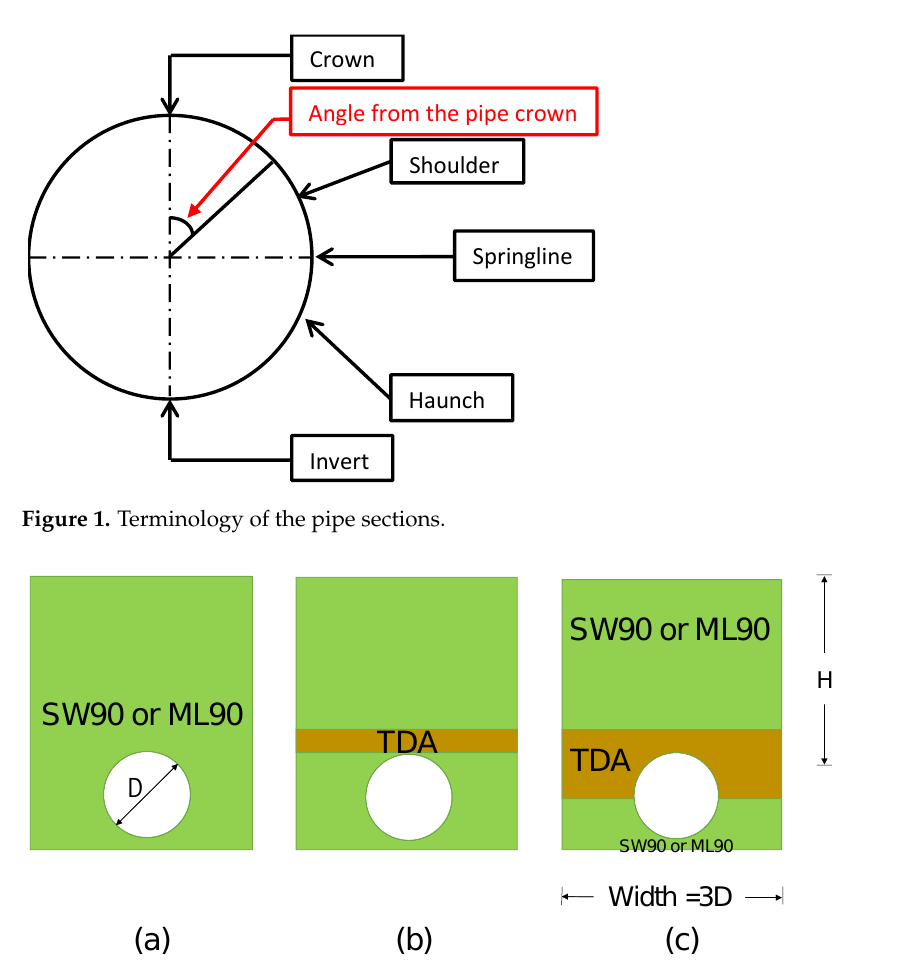
Table 1. The inside diameter of the pipes used in the research.